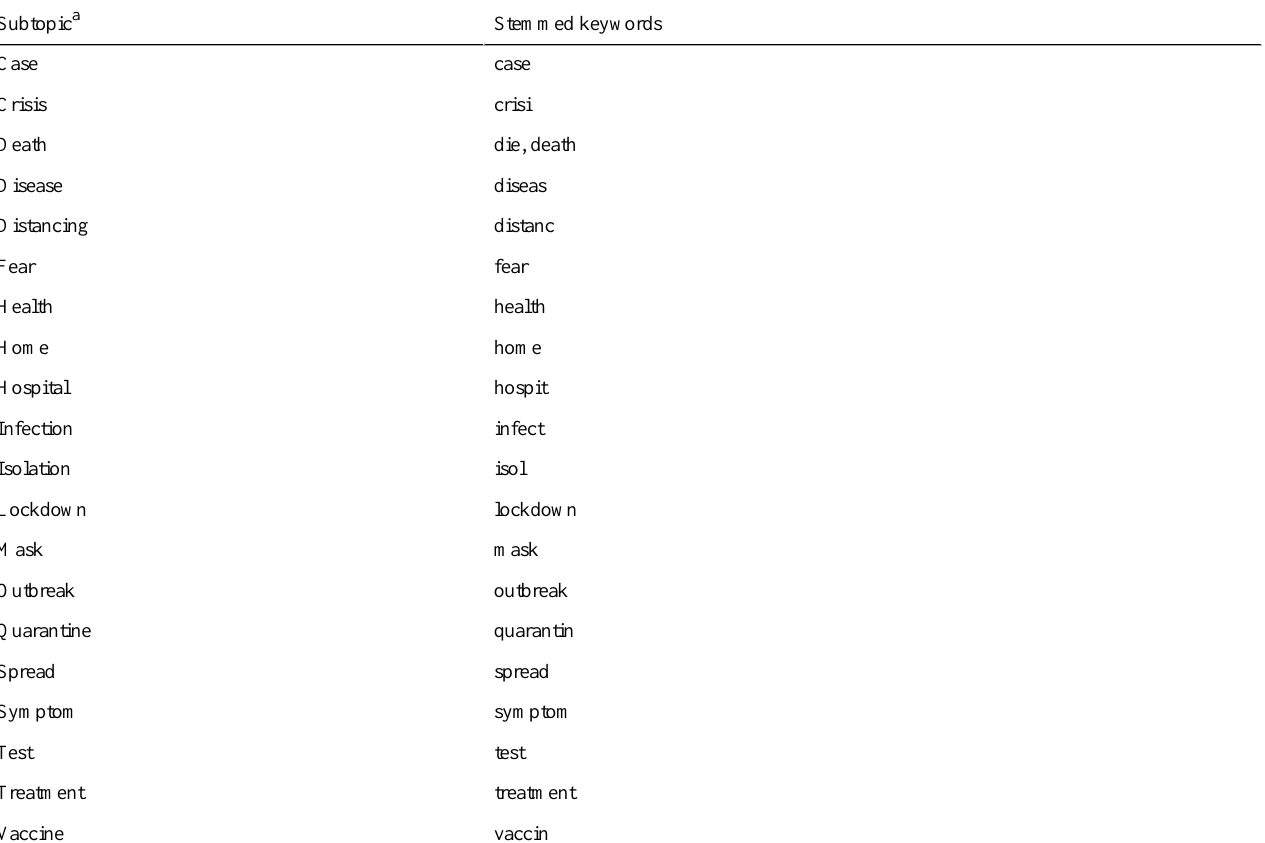
Table 3. COVID-19 news